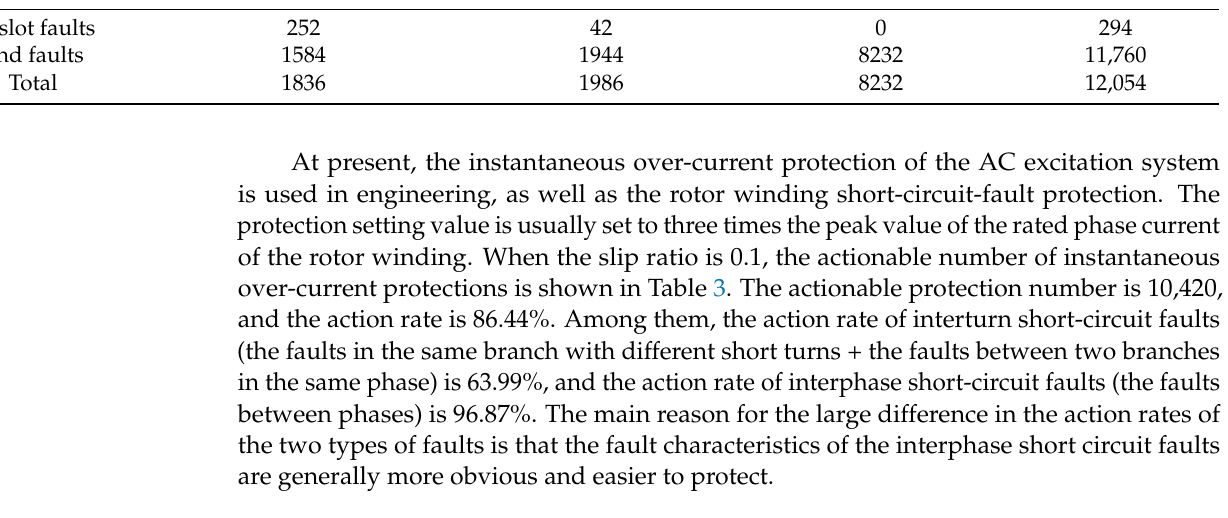
Table 3. The actionable protection number statistical results of the existing